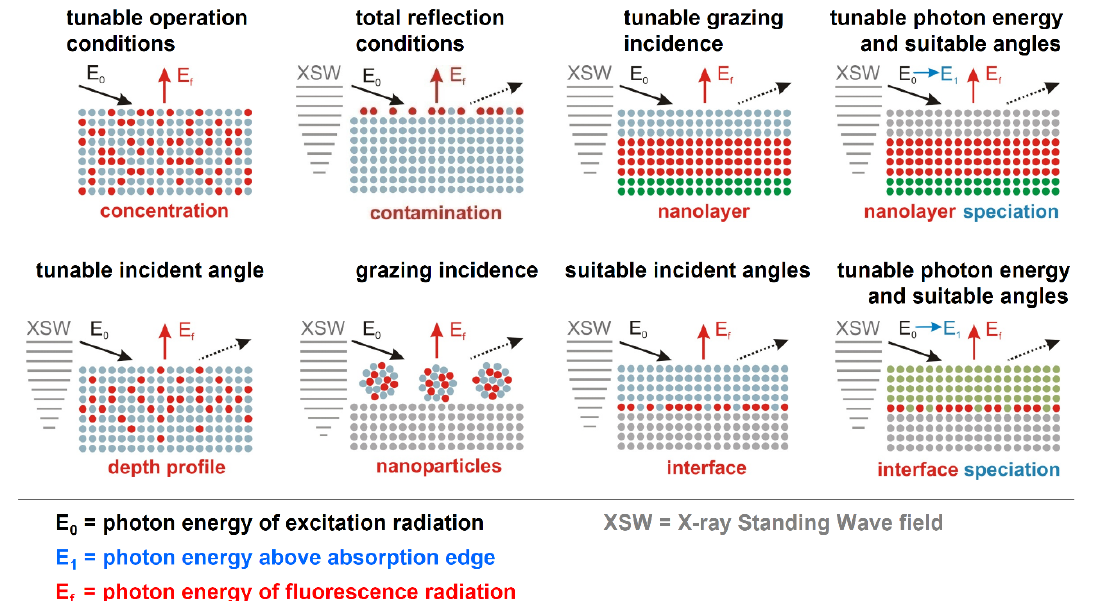
Figure 2. Modifications of SR-based XRS operational conditions for various classes of nanomaterials. The analytical discrimination capability, detection sensitivity, quantification reliability and information depth (driven by the penetration depths) can be favorably modified by an appropriate choice of operational parameters such as the photon energy of the incident radiation and a suitable set of incident angles.